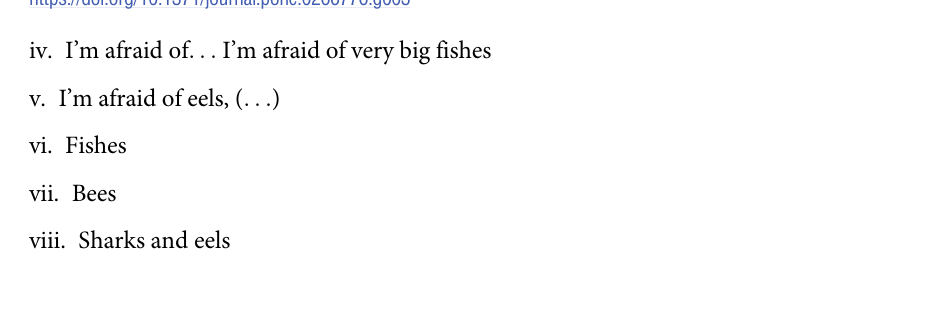
Fig 3. Percentage of students recognizing the existence of elements of the fauna and flora of stream ecosystems over time (M1-M3) in the questionnaires.